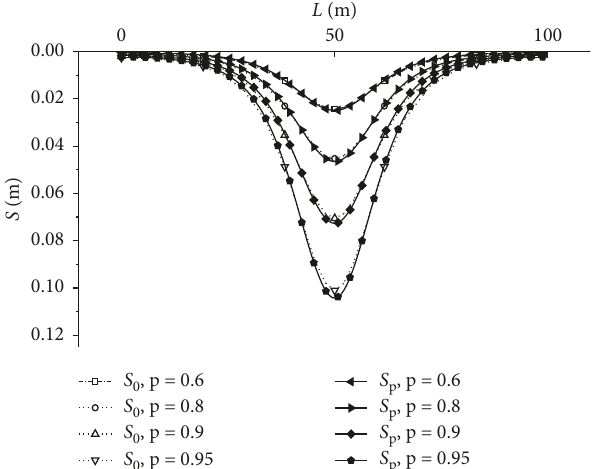
Figure 4: Transverse subsidence of ground surface and pipeline in different stress release rates.